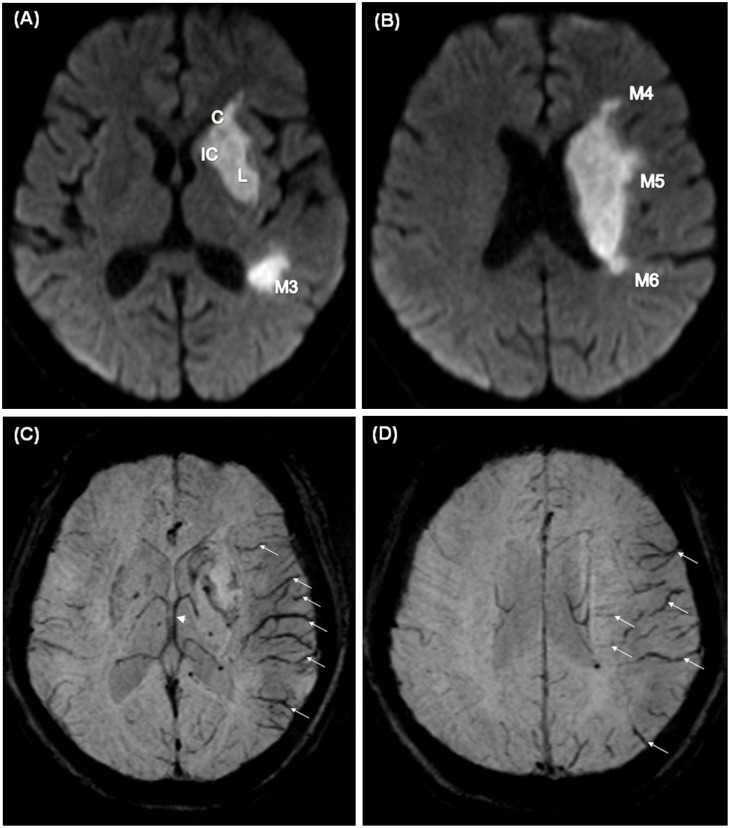
A 63-year-old woman had a diagnosis of left middle cerebral artery territory infarct.The infarct was noted in all 10 zones on diffusion-weighted or susceptibility-weighted magnetic resonance imaging with ASPECTS score = 0. Diffusion-weighted imaging (A,B) at the basal ganglion and suprabasal ganglion levels reveals the infarct in the internal capsule, lentiform nucleus, caudate nucleus, and zones M3, M4, and M5 of the middle cerebral artery. Susceptibility-weighted imaging reveals prominent hypointense cortical and medullary vessels diffusely seen in the insula and M1 to M6 zones of the left middle cerebral artery territory. Engorged deep veins and thalamostriate artery over the lesion side compared with the healthy side were also noted. Involved M1 to M6 zones and insula lost 7 points and an engorged thalamostriate vein lost 3 points. The prominent vessel sign score was 0 (10–7–3 = 0). Susceptibility-weighted imaging (C, D) at the basal ganglion and suprabasal ganglion levels reveals prominent vessel signs in the cortical veins (arrows), medullary veins (arrows) and thalamostriate vein (arrowhead).